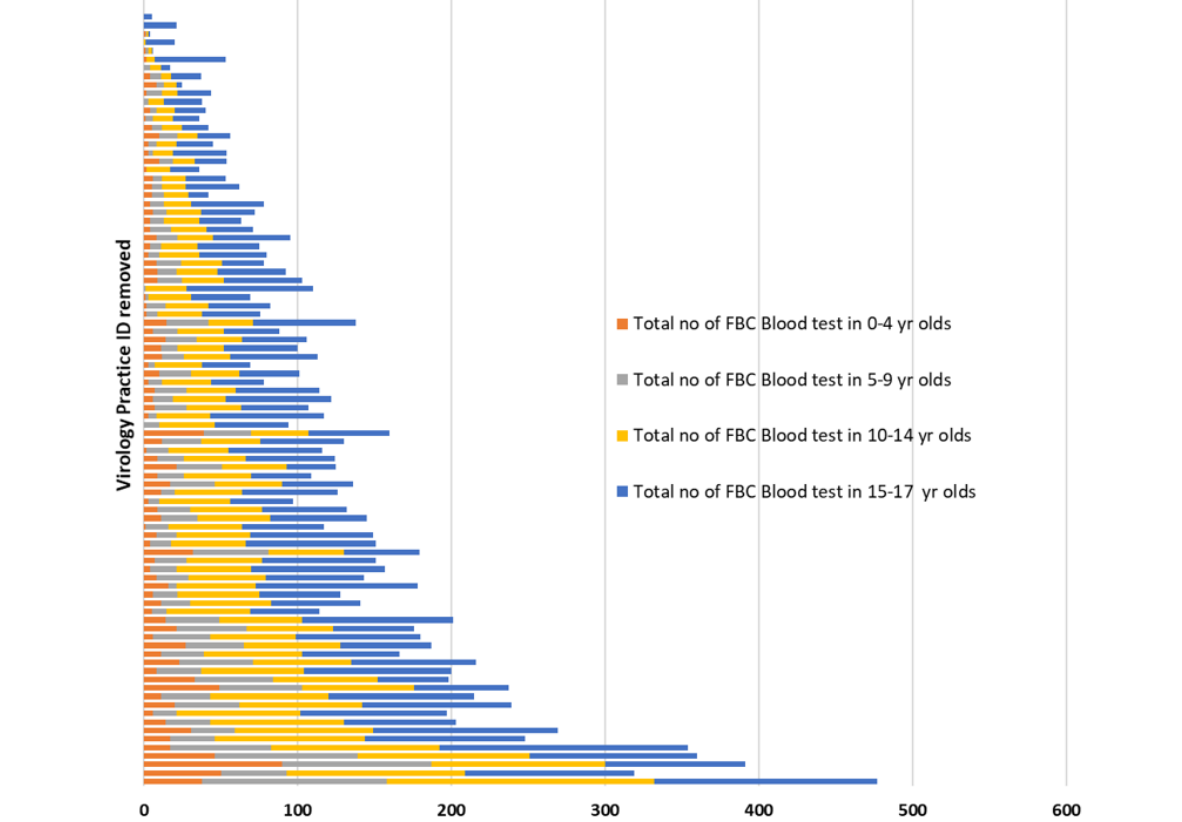
Figure 6. Number of full blood count results in RCGP RSC 2019-2020 virology practices for different child and young adult age groups. Practice unique identifiers have been removed. FBC: full blood